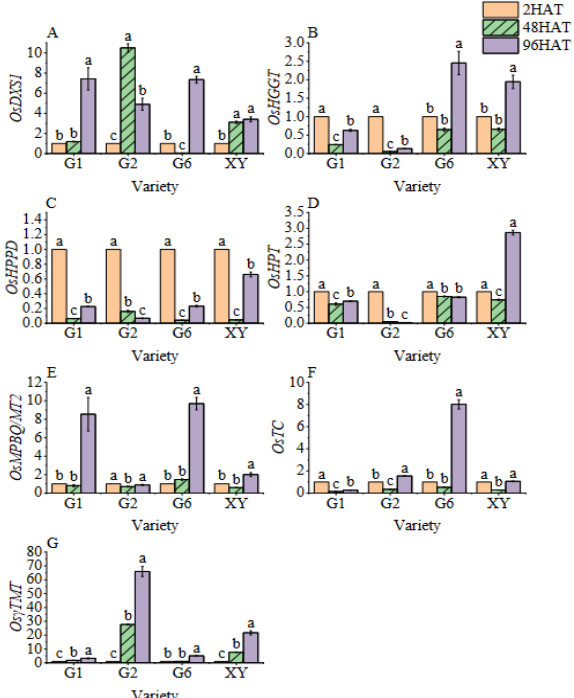
Figure 6. Bar chart of the dynamic changes in vitamin E synthetic gene expression during germination of brown rice. ( A ): The OsDXS1 gene expression. ( B ): The OsHGGT gene expression. ( C ): The OsHPPD gene expression. ( D ): The OsHPT gene expression. ( E ): The OsMPBQ/MT2 gene expression. ( F ): The OsTC gene expression. ( G ): The Os γ -TMT gene expression. Treatments: 2 h after seed soaking treatment (2HAT), 48 h after seed soaking treatment (48HAT), 96 h after seed soaking treatment (96HAT). Varieties: Guanghei1 (G1), Guichao2 (G2), Guanghong6 (G6), Xiangyaxiangzhan (XY). Bars with different letters differ significantly at p <